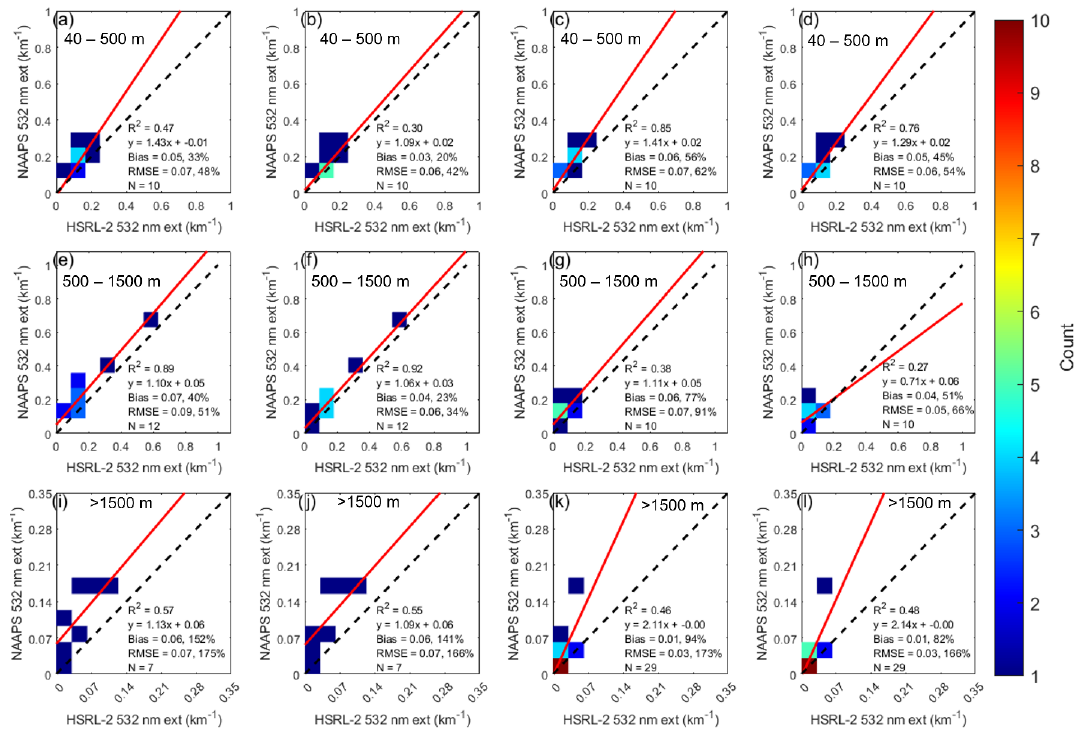
Figure 5. Same as Fig. 4 except when NAAPS-RA overestimated both extinction and RH. Linear fits are indicated with red lines, 1 : 1 lines are shown as dotted lines, and the color bar shows the number of points falling in each bin. Where bias and RMSE are reported, the first and second numbers are the absolute and relative values,